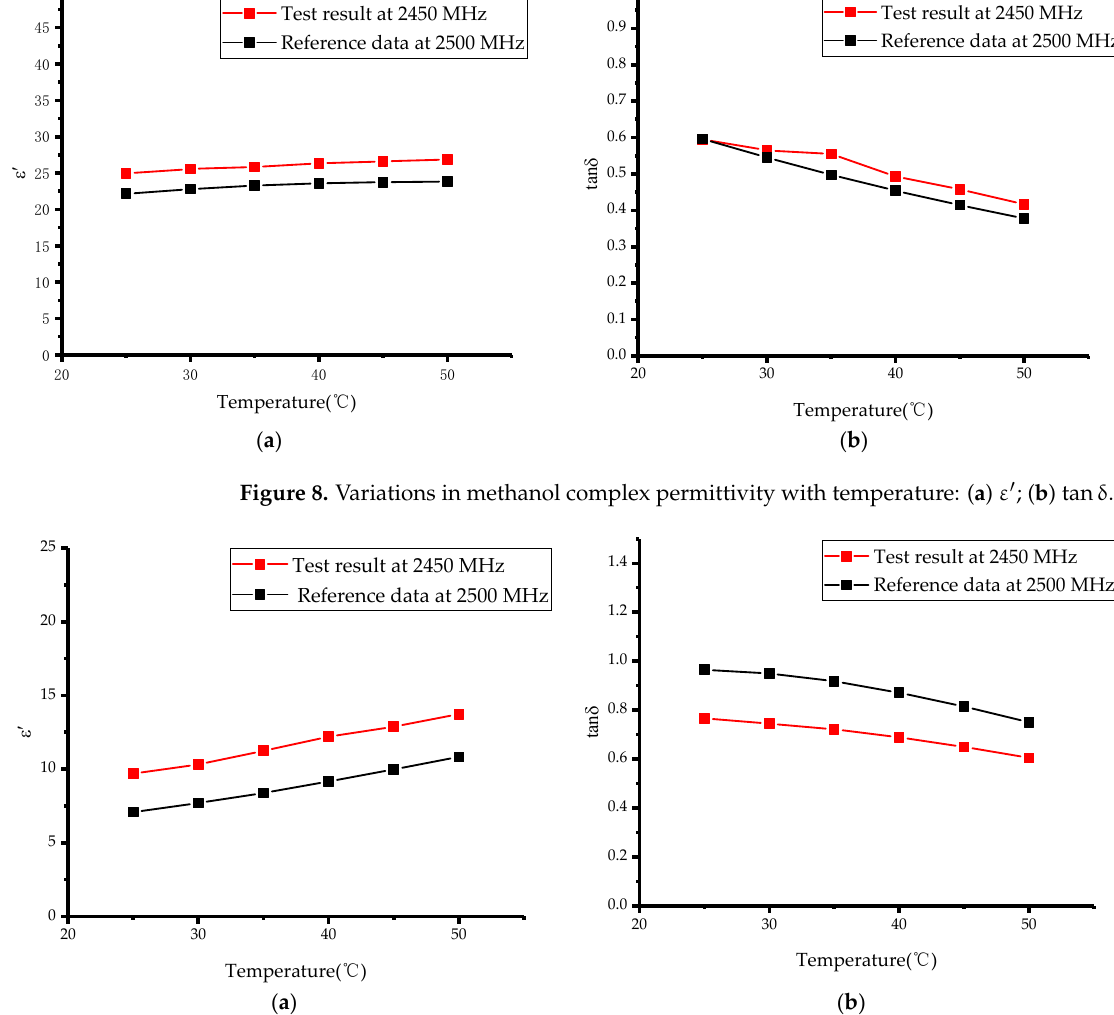
Figure 9. Variations in ethanol complex permi tt ivity with temperature: ( a ) ε (cid:4593) ; ( b ) tan δ . Measurement of the complex permi tt ivity of methanol and ethanol under increasing temperature conditions were compared with the results in [30]. Figures 8 and 9 show that the results of this experiment at 2450 MHz have the same trend as the reference results at 2500 MHz, with only small di ff erences in the speci fi c values. This may be due to the fact that there is a deviation in frequency between the two experiments and the permi tt ivity varies with the frequency, hence, the small deviation in the tested values at the two fre- quencies. In addition, there may be some minor errors in the purity of the organic reagents as well as in network of inversion algorithms, which can also lead to deviations in the measured values, but the accuracy of the measurements are not a ff ected. In summary, we experimentally veri fi ed the accuracy and reliability of this microwave heating and com- plex permi tt ivity measurement system. Moreover, we designed the system to use a quar tz tube as a container for the material to be measured, thus, avoiding direct contact between the material and the measuring device, and allowing the measurement of the complex permi tt ivity of corrosive materials. 4. Discussion In this paper, a system for microwave heating and measurement of the complex per- mi tt ivity was designed based on the transmission/re fl ection method, and it was experi- mentally veri fi ed that the system could achieve rapid and accurate measurement of the